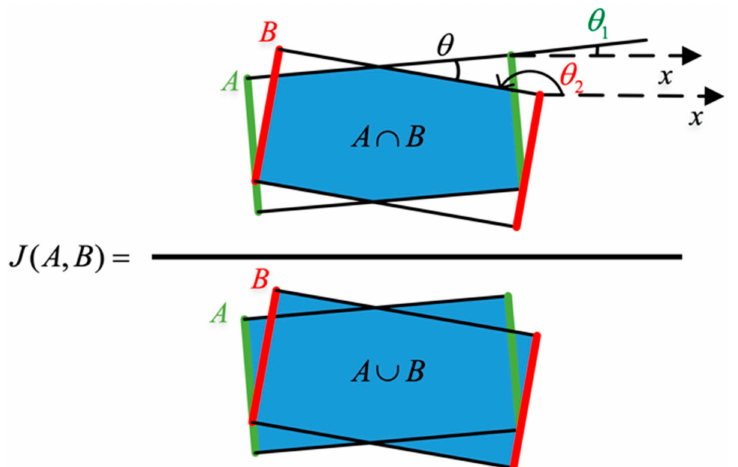
Figure 4. Jaccard